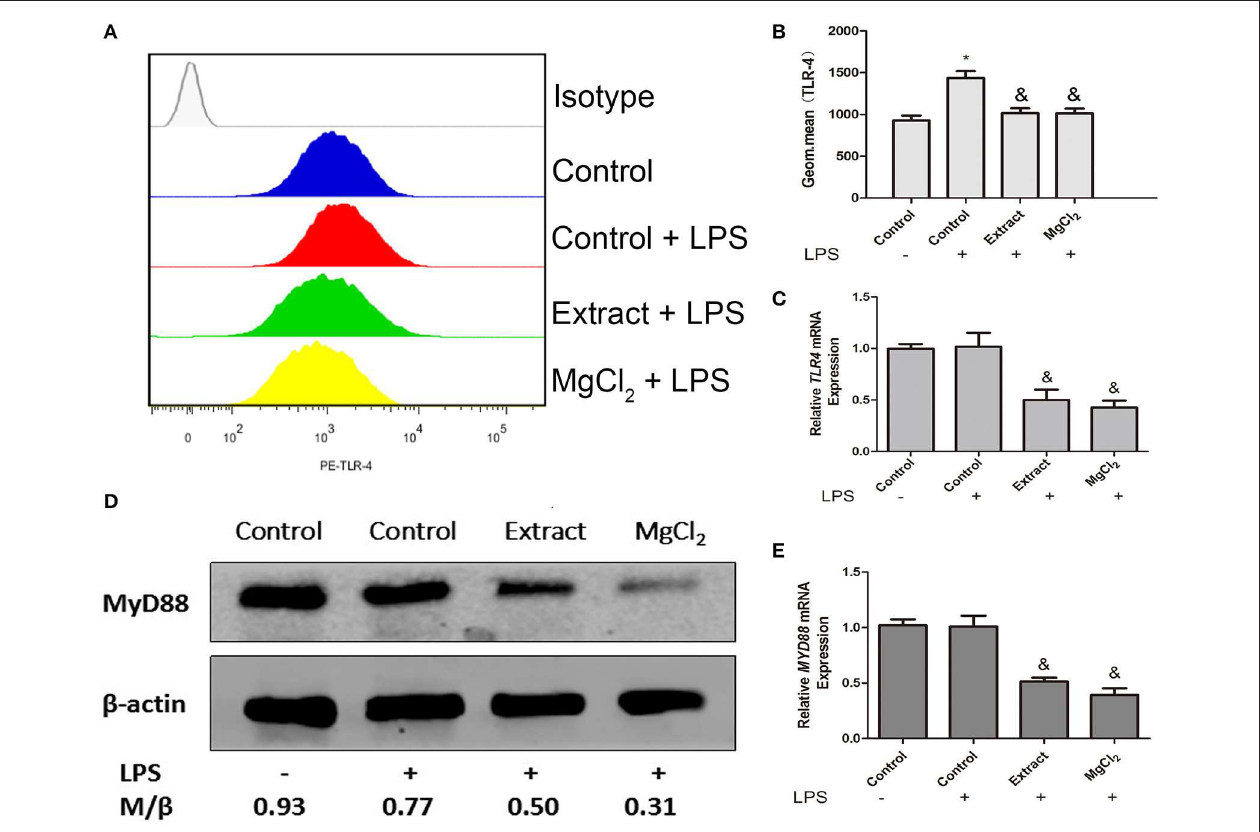
FIGURE 5 | Effects of extract and MgCl 2 on TL-4–MYD88-dependent signaling pathway in THP-1 cell-derived macrophages. THP-1 cell-derived macrophages were pretreated with MgCl 2 or extract for 1h prior to challenge with LPS for another 24h. The expression of TLR-4 was analyzed by FACS (A,B) , and MYD88 was detected at the protein level using western blotting (D) . The expression of TLR-4 and MYD88 was measured at the mRNA level using real-time PCR (C,E) . The representative images from three experiments are shown. * P < 0.05 vs. control group; & P < 0.05 vs. LPS-induced control group. LPS, lipopolysaccharide; FACS, fluorescence-activated cell